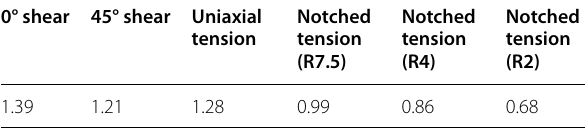
Table 3 The fracture strain of specimens under different stress